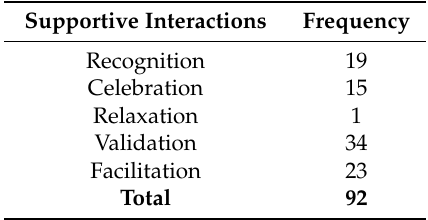
Table 2. Frequencies of supportive